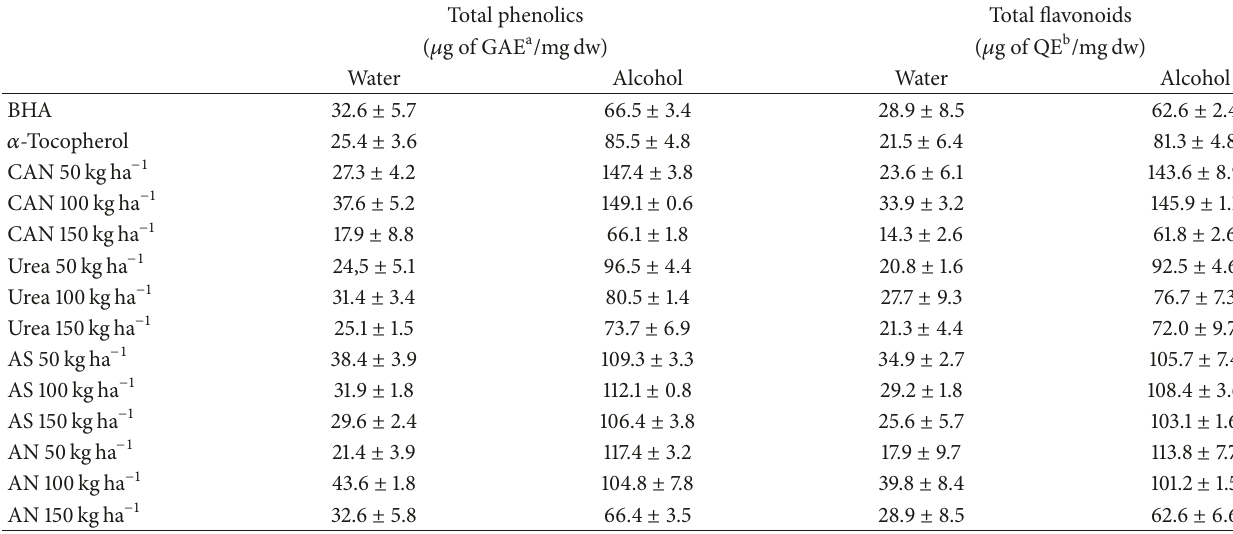
Table 1: Total phenolic content and total flavonoids amounts of water extracts, alcohol extracts, 𝛼 -tocopherol, and BHA. Total phenolics Total